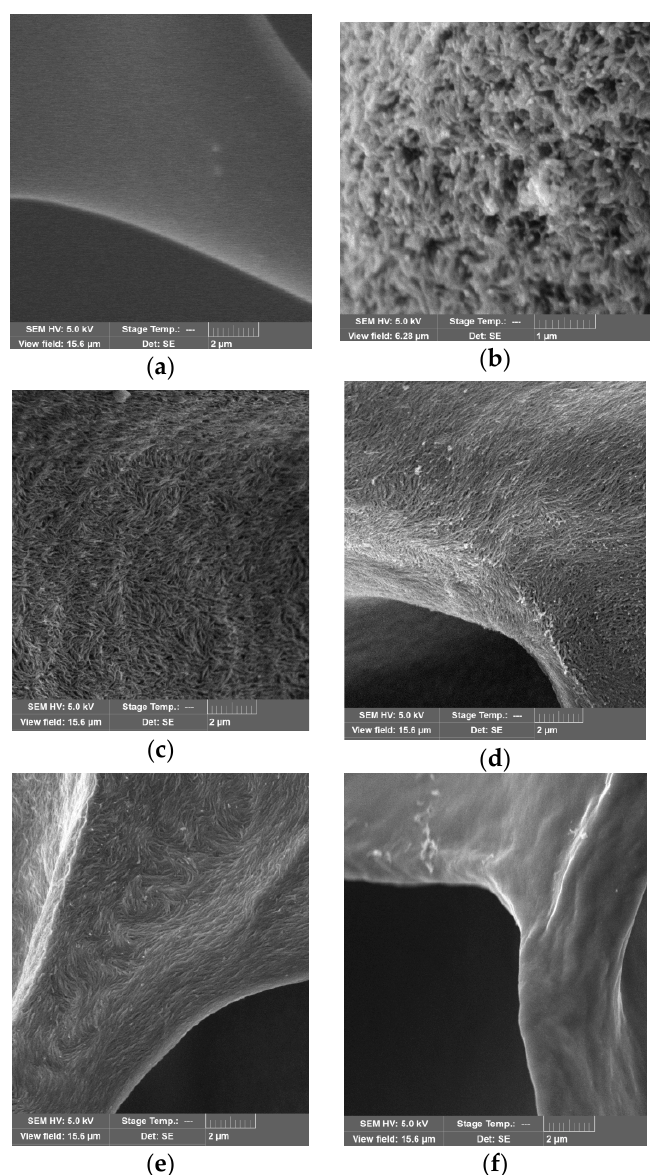
Figure 9. SEM images of the neat PVP aerogel ( a ) and the PVP/CNC composite aerogels with CNC content (wt.%) of: 4.6 ( b ); 10.9 ( c ); 19.6 ( d ); 28.9 ( e ); 70.6 ( f ), respectively. Scales: 2 µ m ( a , c , d , e , f ); 1 µ m ( b ).